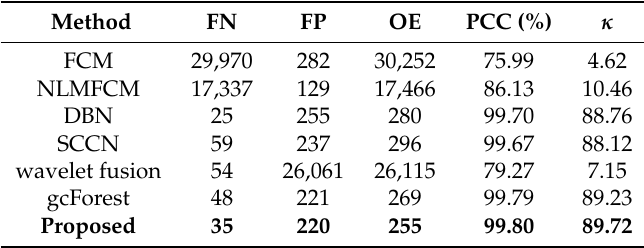
Table 4. Value of the evaluation criteria of the coastline data